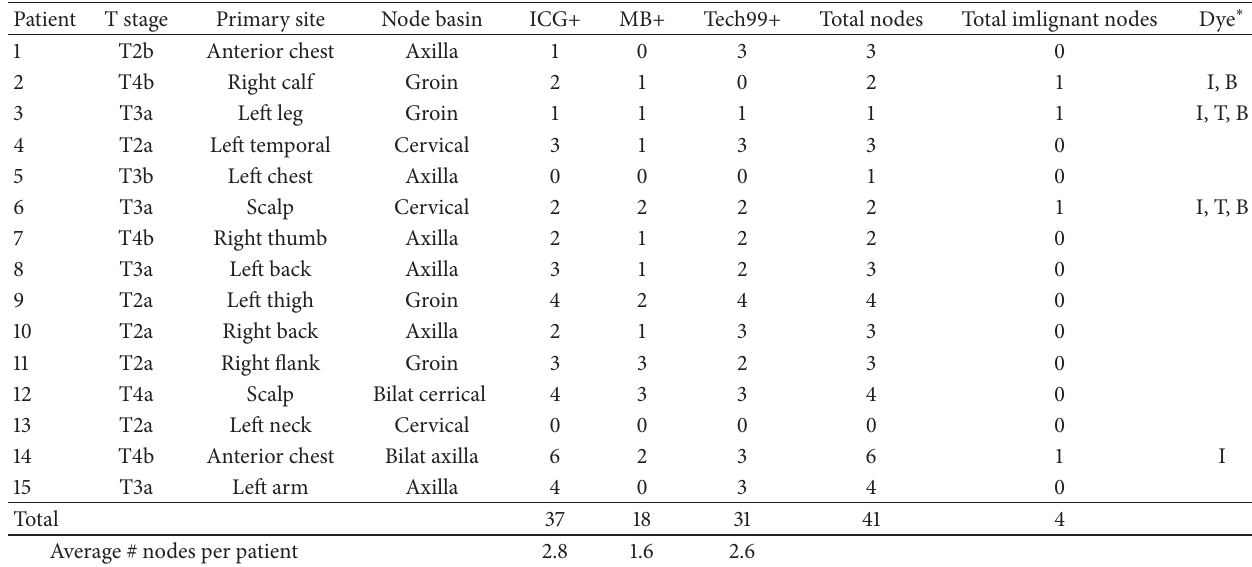
∗ Dye: I: ICG, B: MB, T: